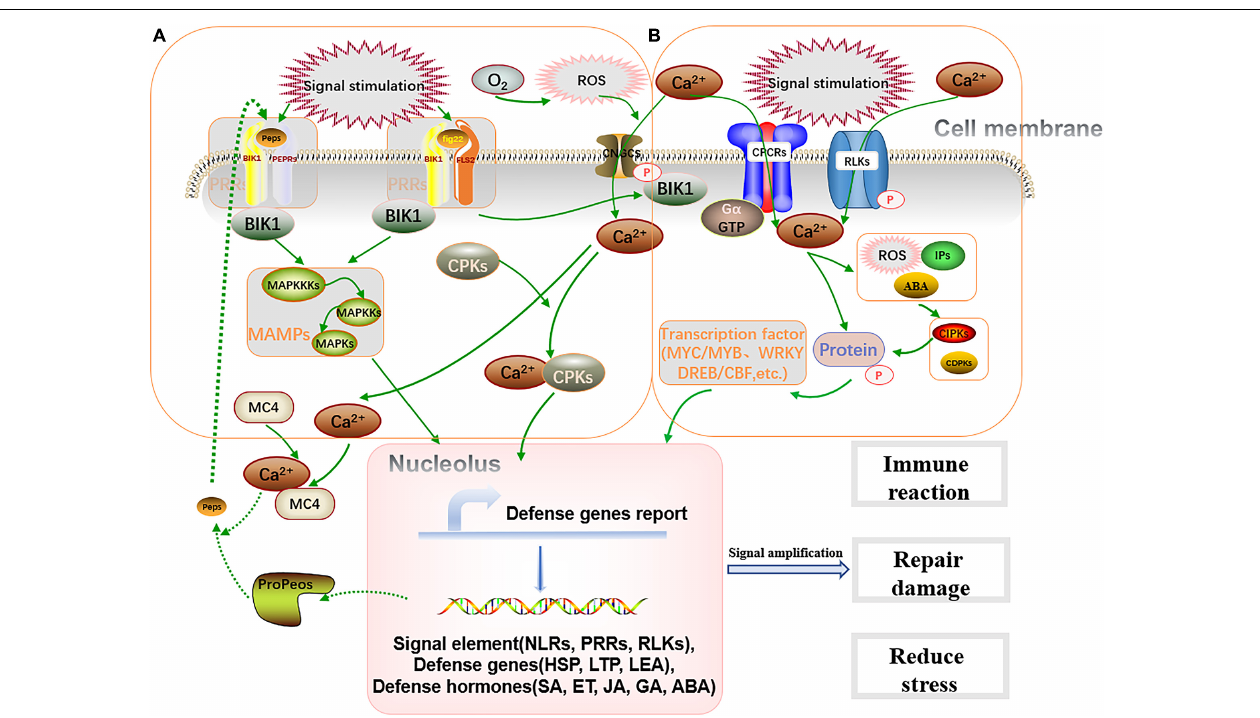
FIGURE 3 | Endophytes regulate the tolerance of plants to stress. (A) Under stress environment, endophytes can produce exogenous signals and quickly activate plant PRRs membrane receptors. On the one hand, they activate the downstream MAPKs level connection On the other hand, they regulate the intracellular Ca 2 + concentration. (B) Under the action of exogenous signal of endophytes, membrane receptors such as CPCRs and RLKs are activated to induce downstream reaction. Cascade signaling is transmitted in the nucleus to promote the expression of relevant response genes, so as to improve the ability of host in immune response, repair damage and reduce